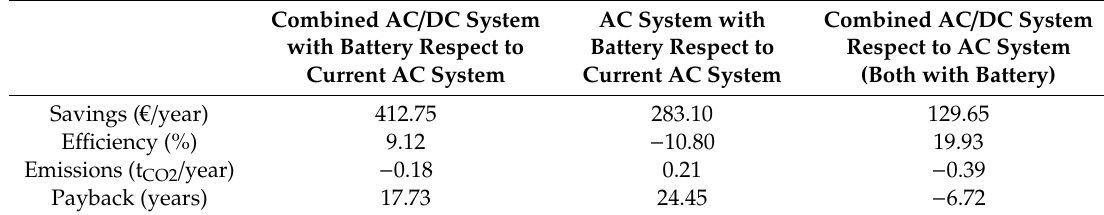
Table 2. Comparison of the systems